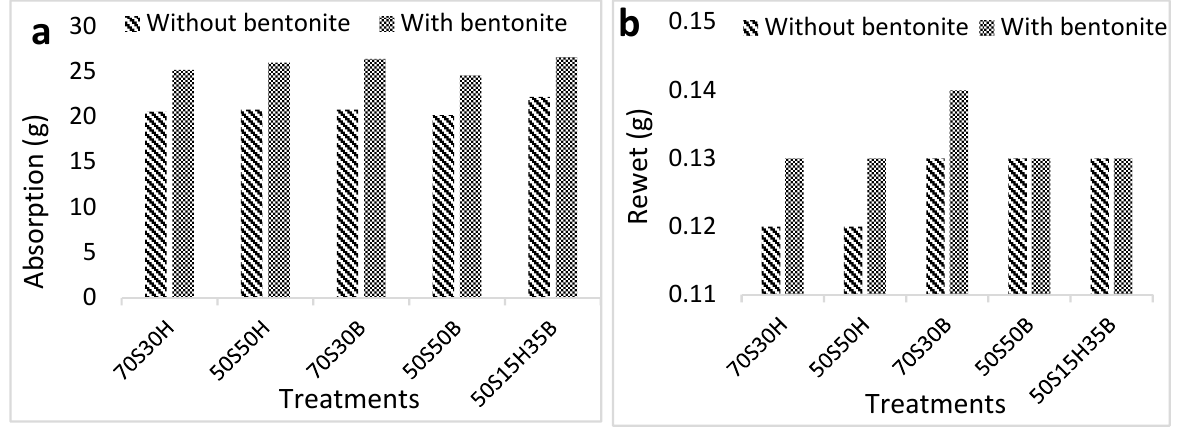
Figure 8. Absorption capacity ( a ) and rewet ( b ) of sanitary napkins produced with different fluff pulp formulations.